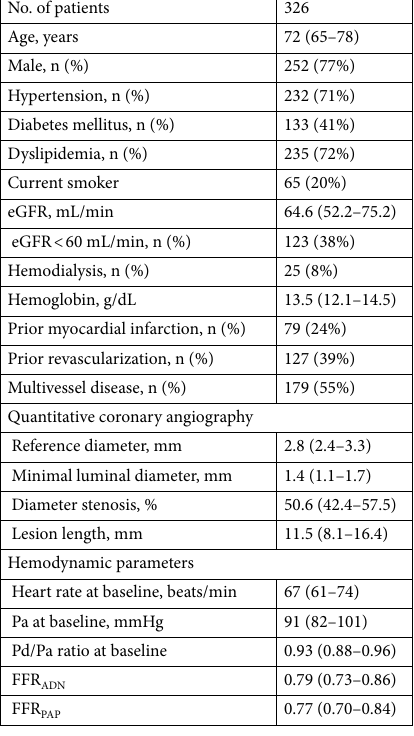
Table 1. Patient and lesion characteristics. Values are expressed as medians (interquartile ranges) or numbers (percentages). eGFR estimated glomerular rate, FFR ADN fractional flow reserve value associated with adenosine, FFR PAP fractional flow reserve value associated with papaverine, LAD left anterior descending coronary artery, LM left main coronary artery, Pa mean aortic pressure, Pd mean distal coronary